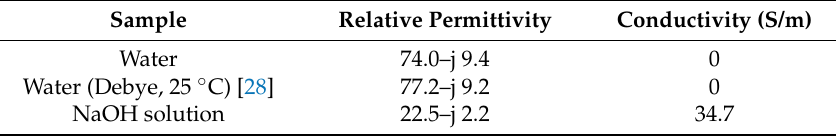
Figure 12. Estimated results of the imaginary part of the relative permittivity for the NaOH solution. The conductivity of the NaOH solution was set to 34.7 S/m. The conductivity effect was not taken into account for the water. Table 2. The relative permittivity and conductivity were taken into the simulation model at 2.45 GHz.